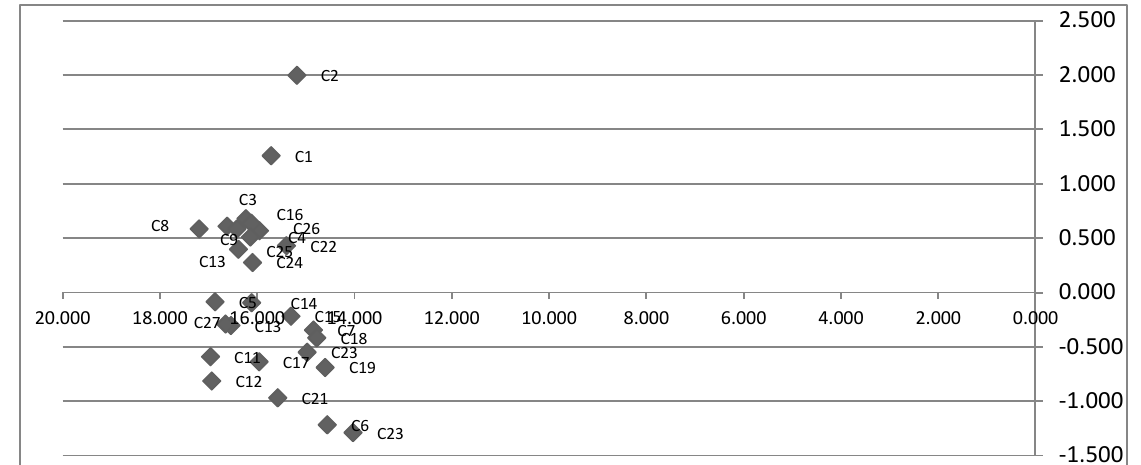
Fig. 4. Cartesian coordinate graph of the output of the Demeter method for